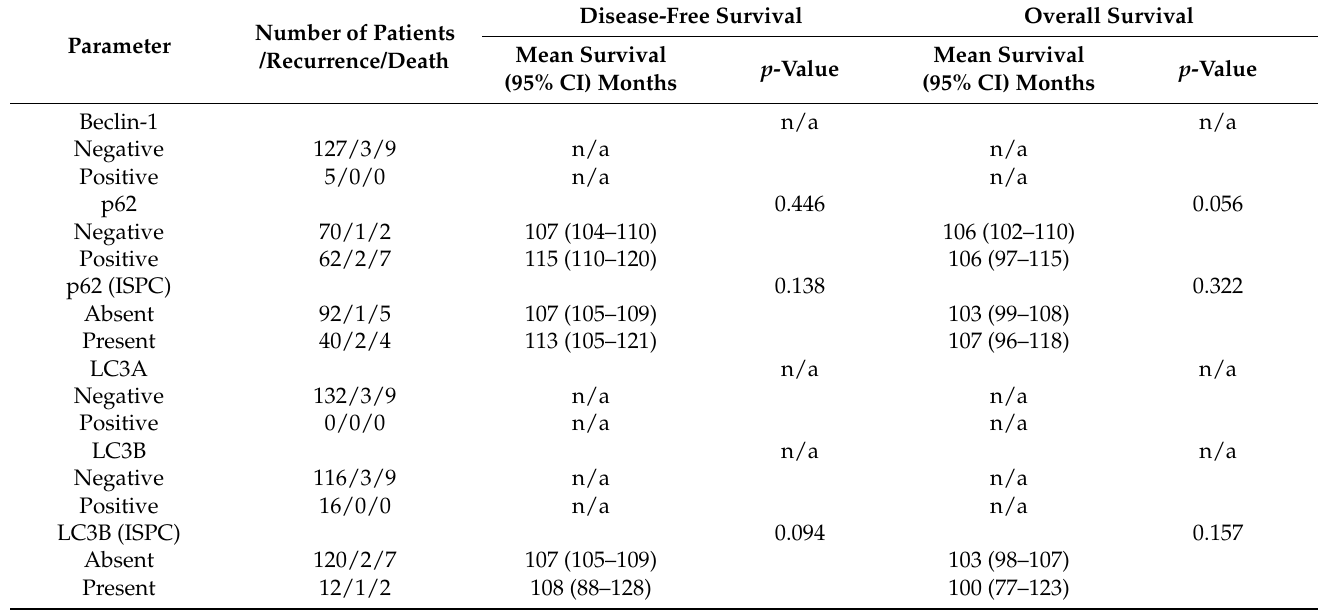
Table 6. Univariate analysis of the impact of expression of autophagy-related proteins in adrenal cortical tumors on disease-free survival and overall survival by the log-rank